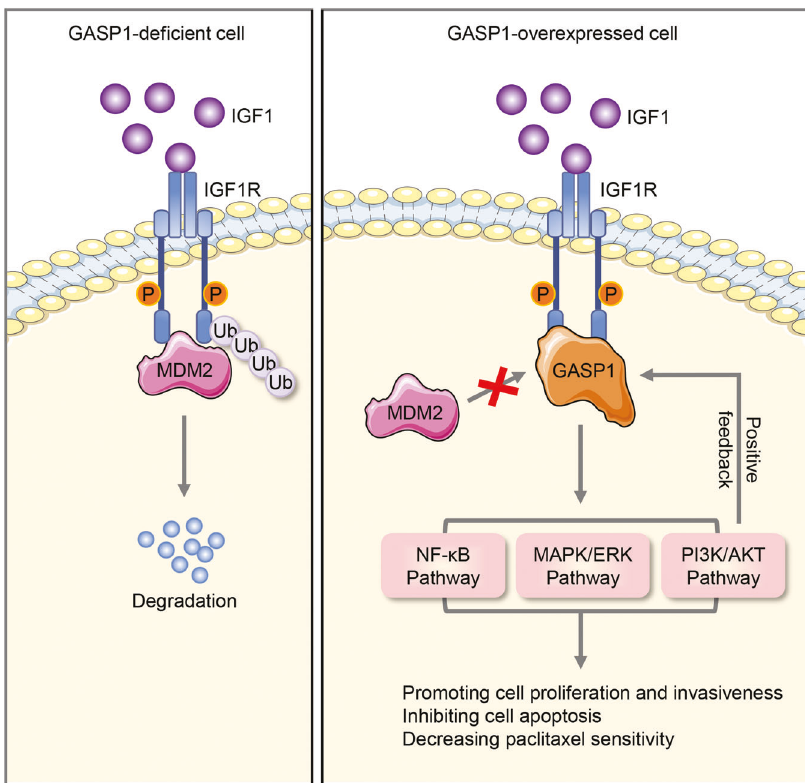
Fig. 7 A schematic model of GASP1 promoting malignant phenotypes of breast cancer cells and decreasing their response to paclitaxel by forming a positive feedback loop with the IGF1/IGF1R pathway. In GASP1-de fi cient cells, IGF1R stability can be regulated by MDM2- mediated ubiquitination degradation. When GASP1 is overexpressed in breast cancer, GASP1 interacts with and stabilizes IGF1R by preventing the MDM2-mediated IGF1R ubiquitination degradation, thereby activating its downstream signaling pathways such as NF- κ B, PI3K/AKT, and MAPK/ERK pathways. IGF1, in turn, stimulated GASP1 expression by activating the PI3K/AKT pathway, forming a vicious cycle propelling the malignant progression of breast cancer and decreasing the cellular response to paclitaxel in breast